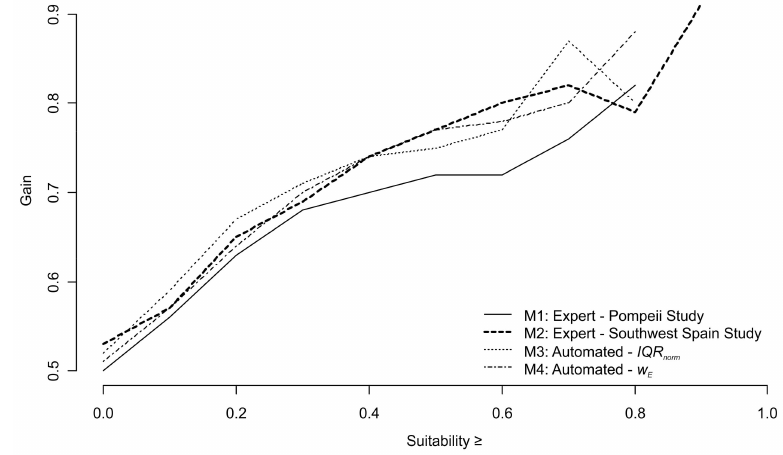
Figure 10. Gain versus suitability plot of the predictive models. The tabulated gain statistic can be found in the Appendix A (Table